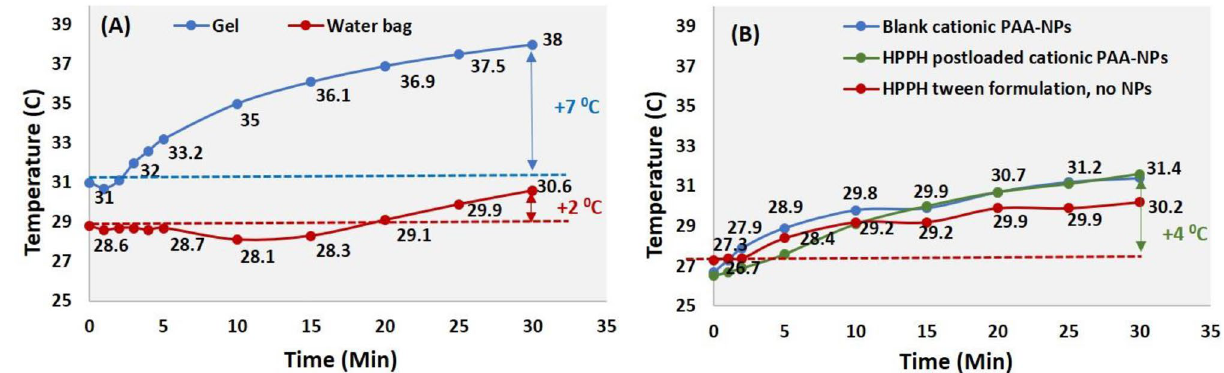
Figure 6. In vivo U87 Glioma tumor temperature during 30 min continuous US exposure (0.5 W/cm 2 , 3.3 MHz) ( A ) Gel applied either on top or tumor or was covered with a water bag [control experiment] and ( B ) either blank cationic PAA-NMe 3+ NPs (10 mg/ml) or HPPH post-loaded cationic PAA-NMe 3+ NPs formulation, or HPPH Tween-80 formulation (HPPH conc: 0.47 µmol/kg) were injected intravenously. After 24 h post- injection, the tumors covered with a water bag were irradiated with US (0.5 W/cm 2 , 3.3 MHz) and the tumor temperature was measured at from 0 to 30 min in 1 min